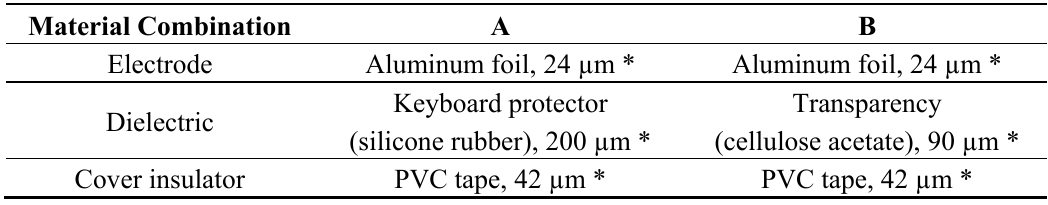
Table 1. Material combination for an electroadhesion